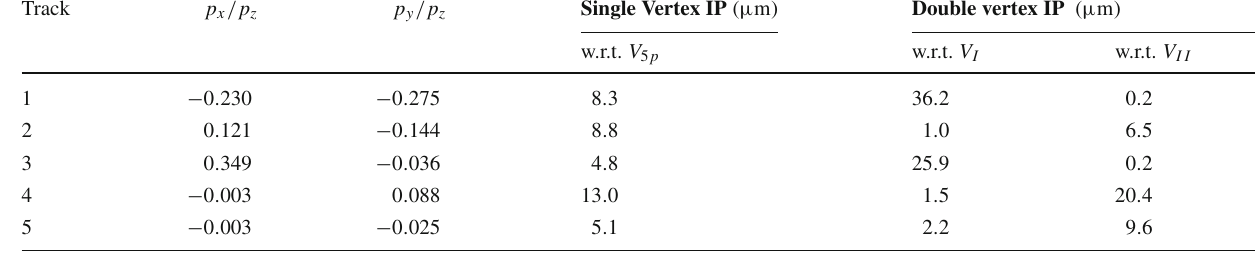
Table 1 Track slopes p x / p z and p y / p z at film 32 and their impact parameters (IPs), evaluated assuming a single vertex topology ( V 5 p ) and a double vertex one. Errors on IP values are evaluated to be of the